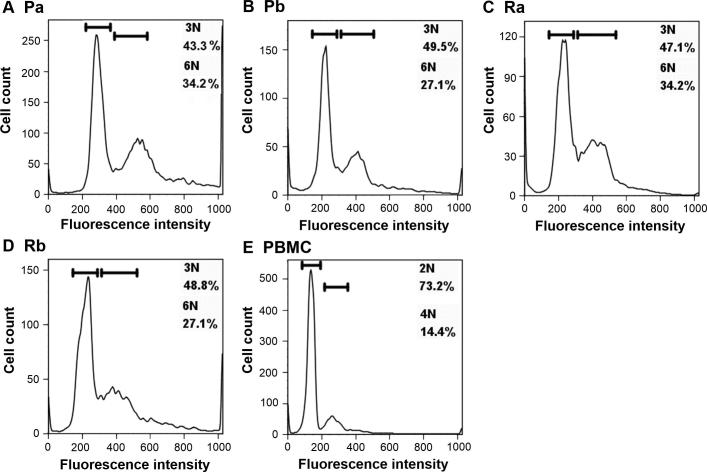
Ploidy analysis for cell clones using flow cytometry Pa cells. B. Pb cells. C. Ra cells. D. Rb cells. E. Human PBMC as normal cell control. PBMC, peripheral blood mononuclear cell.